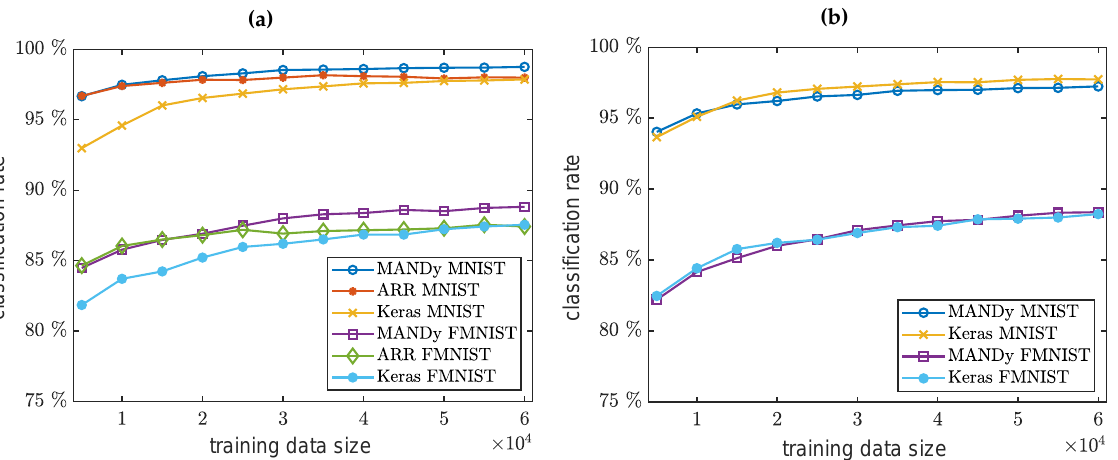
Figure 5. Results for MNIST and fashion MNIST: ( a ) Classification rates for the reduced 14 × 14 images. ( b ) Classification rates for full 28x28 images. Reducing the image size by averaging over groups of pixels improves the performance of the